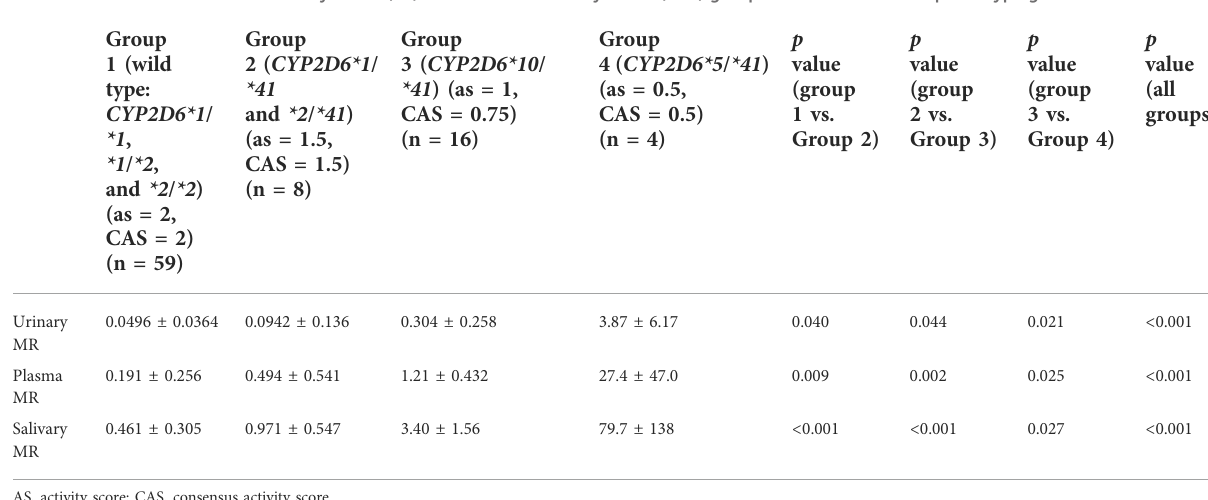
BMI, body mass index; AS, activity score; CAS, consensus activity score.